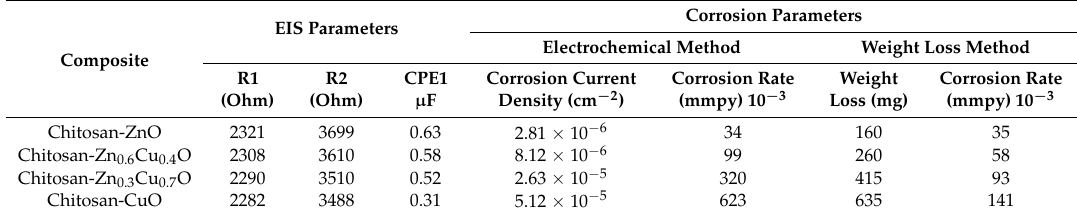
Table 1. EIS and corrosion parameters of electrosynthesized composite thin